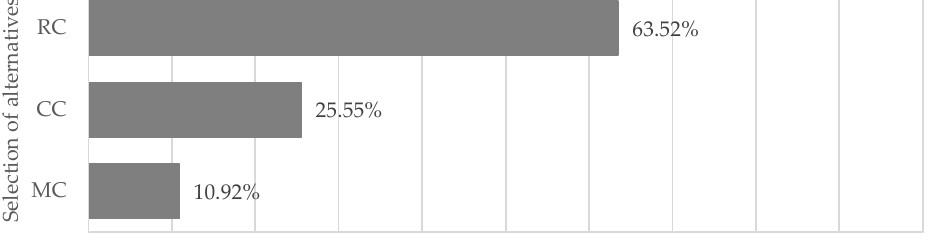
Figure 9. Hierarchical alternatives.